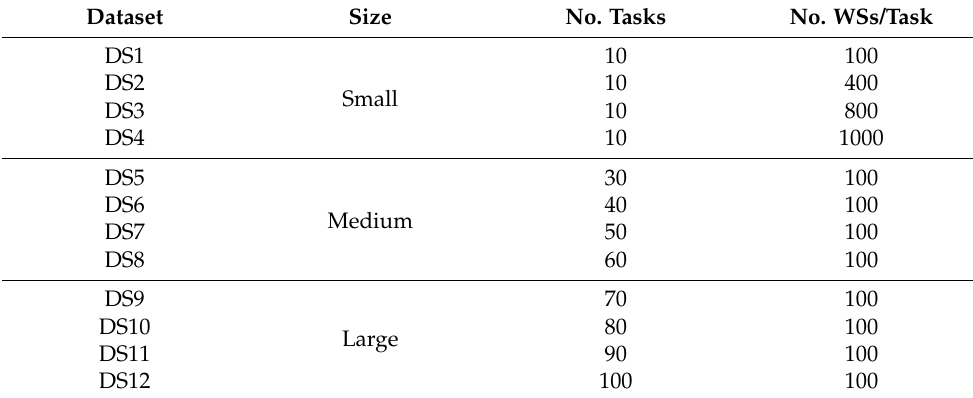
Table 2. Dataset